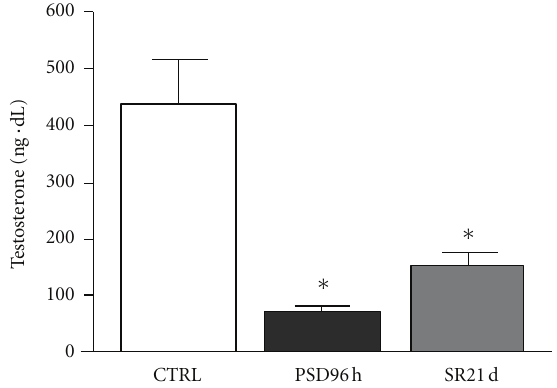
Figure 1: Mean ± SD concentration of serum testosterone (in ngdL − 1 ) control group (CTRL), paradoxal sleep deprivation (PSP) and sleep restriction (SR) at di ff erent time points. ∗ Di ff erent from control group ( P < 0 . 01).